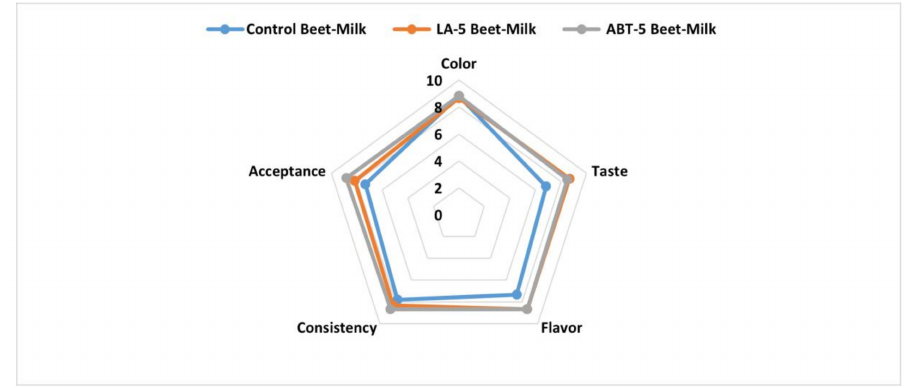
Figure 6. Sensory evaluation of control and fermented beet-milk beverages with LA-5 and ABT-5 probiotic